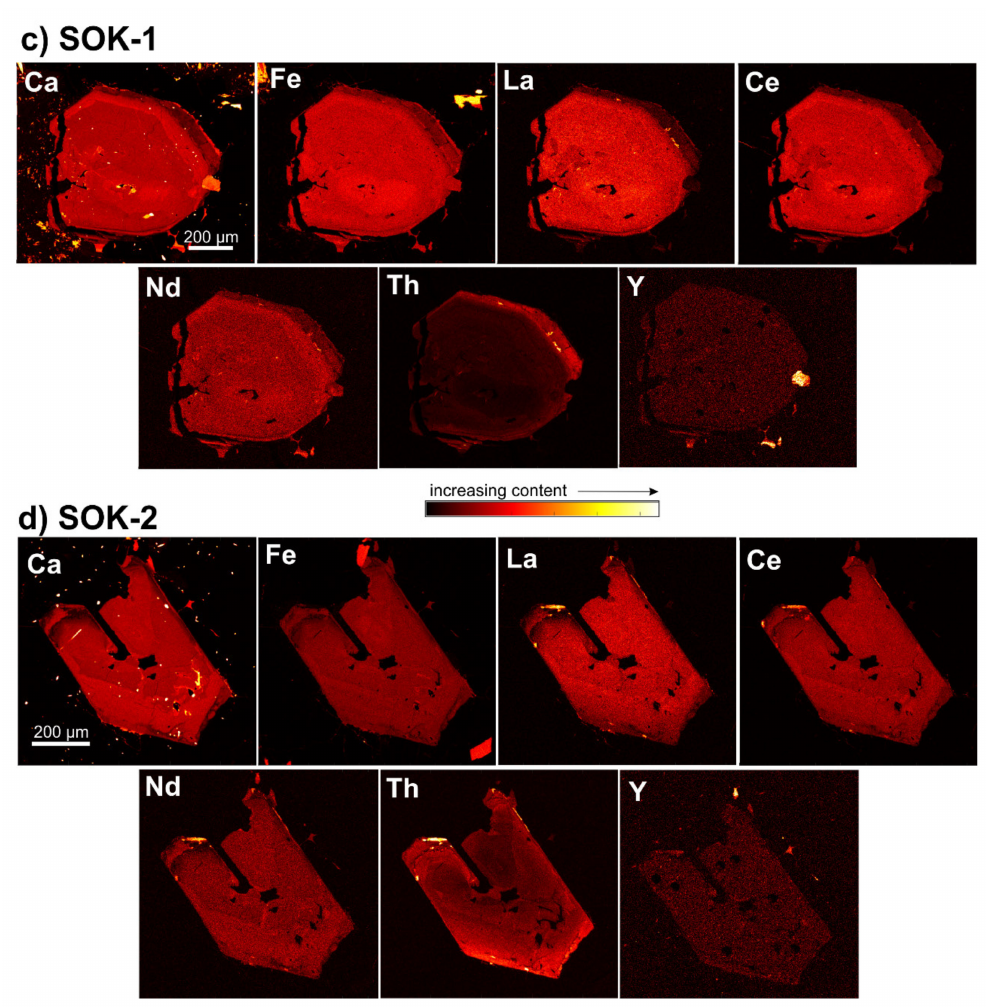
Figure 7. X-ray maps of selected elements for Gruszk ó w and Sokoliki allanite grains. ( a ) grain GR-1; ( b ) grain GR-2; ( c ) grain SOK-1 and ( d ) grain SOK-2. Black spots in Y X-ray maps are after LA-ICP-MS analyses. The scale is shown only for Al ( a , b ) and Ca ( c , d ) maps and is identical for all related